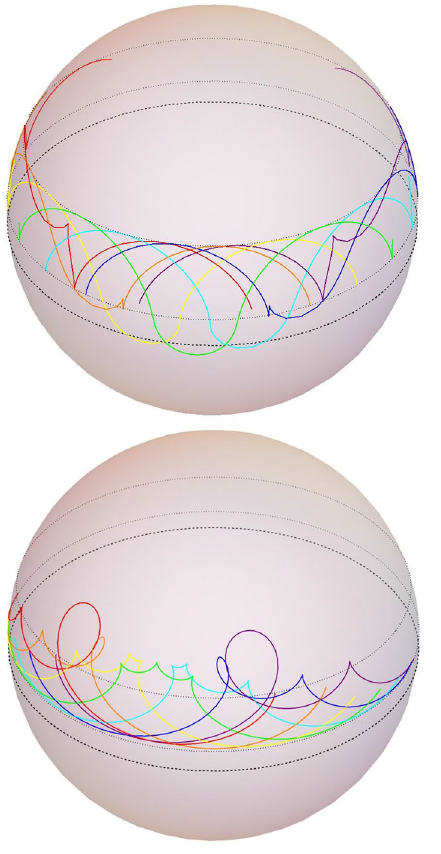
Fig. 21 Two kinds of spike interactions. On the top a spike and anti- spike annihilate and regenerate at a different position. On the bottom a loop dissolves to two spikes. Then, one of those is recombined with another one to form again a loop. The time evolves from the red curve to the purple